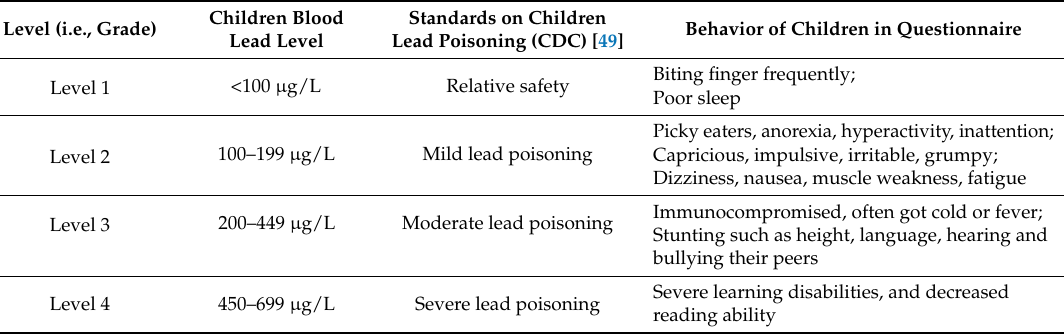
Table 2. The relationship between children’s behaviors and the level of blood lead.